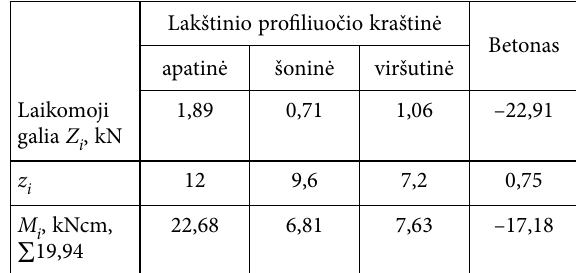
y , i Table 9. Calculation of the moment resistance of one